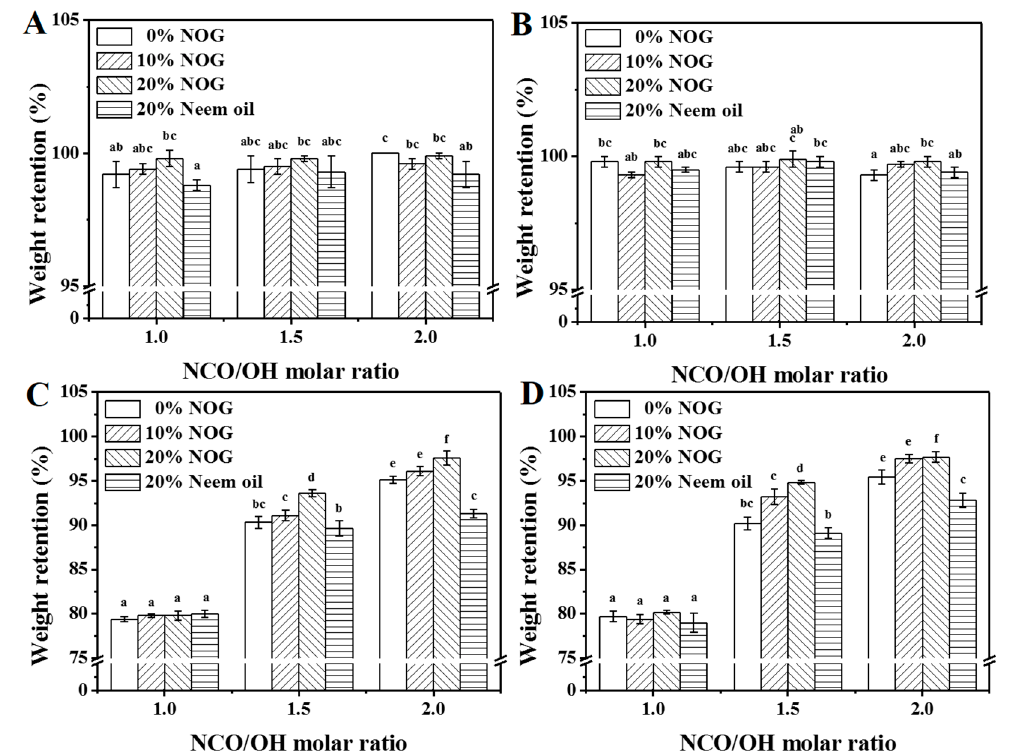
Figure 8. The weight retention of PU foams immersed in 25 °C ( A ) and 50 °C ( B ) distilled water, acetone ( C ) and ethyl acetate ( D ) for 1 h. The NCO/OH molar ratios of O1-2, O2-2 and O3-2 set as 1.3, 1.9 and 2.5, respectively. The data analyzed using one-way ANOVA with Scheffe’s test, the different lowercase letters indicate statistical differ-ences in the bar graph.